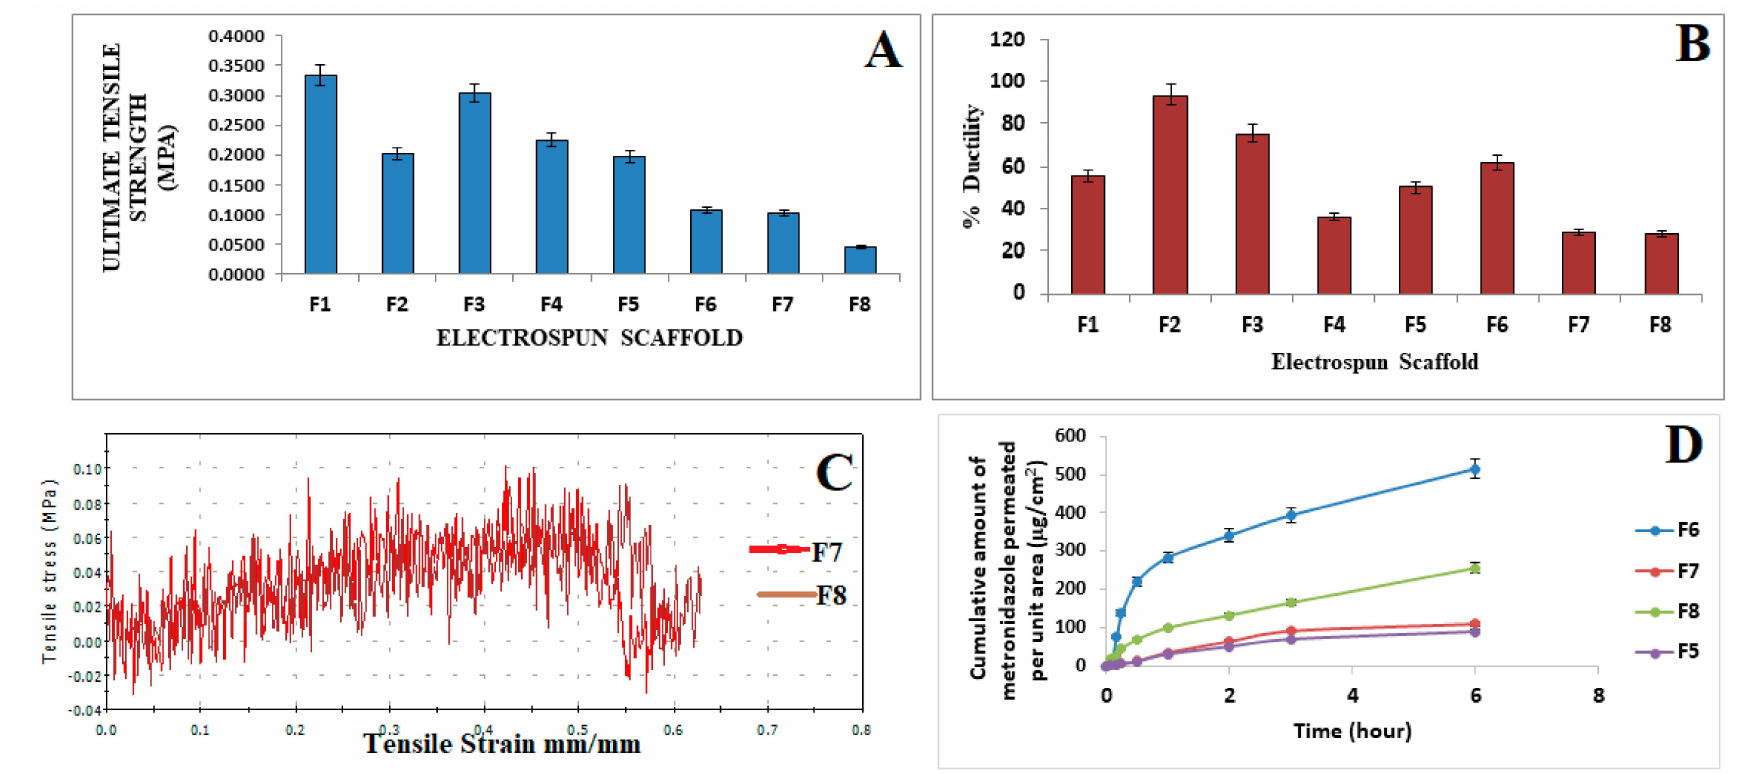
Figure 3. ( A ) Ultimate tensile strength of electrospun scaffolds, ( B ) Ductility of electrospun scaffolds, ( C ) Tensile strain vs. tensile stress of electrospun fibers F7 and F8, and ( D ) Cumulative Amount of metronidazole permeated per unit ( µ g/cm 2 ) vs. time in